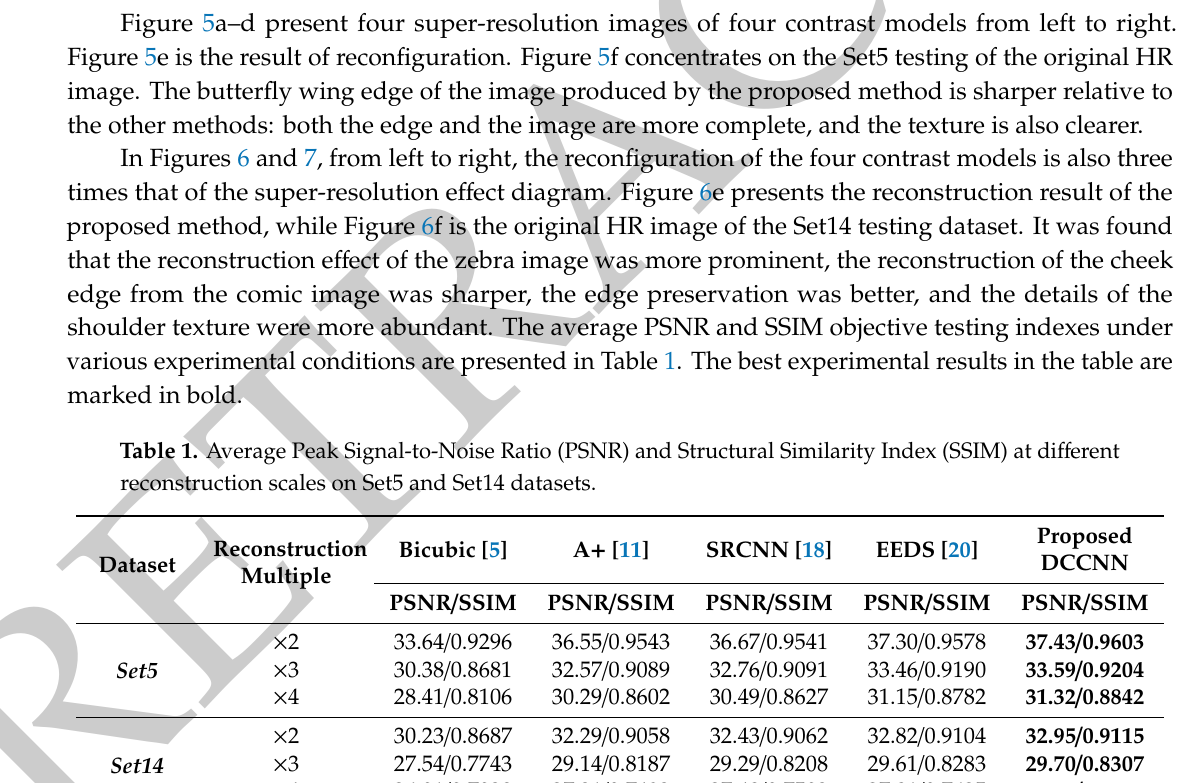
Figure 7. Super-resolution reconstruction results of the image “Comic” with “ × 3” scale factor. ( a ) Bicubic [5]; ( b ) A + [11]; ( c ) SRCNN [18]; ( d ) EEDS [20]; ( e ) The Proposed Method; ( f ) Original Image. Table 1. Average Peak Signal-to-Noise Ratio (PSNR) and Structural Similarity Index (SSIM) at different reconstruction scales on Set5 and Set14 datasets.